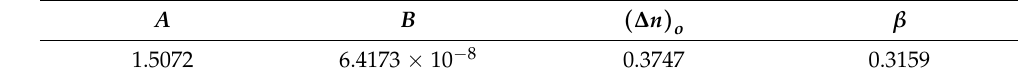
Figure 8. ( a ) Graph of nonlinear fitting using the experimental data of the ratio of n o and n e , and ( b ) the refractive indices of n o , n e , and (cid:104) n (cid:105) according to the temperature obtained by applying the four constant values.